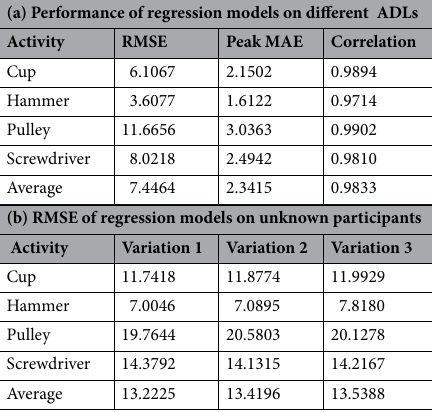
Table 1. (a) Performance measures for generic regression models trained with the data of all participants. (b) Performance measure for regression models trained with the data of a few participants and tested on unknown participants with three different variations. Variation 1 tested on two unknown participant, variation 2 tested on three unknown participants, and variation 3 tested on four unknown participants. Units for RMSE and Peak MAE are deg/s.